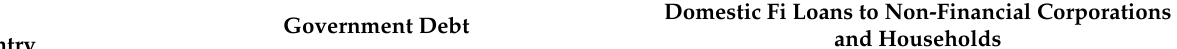
Table 3. Selected macroeconomic characteristics of countries targeting inflation (2020, % of GDP). Domestic Fi Loans to Non-Financial Corporations Government Debt and Country